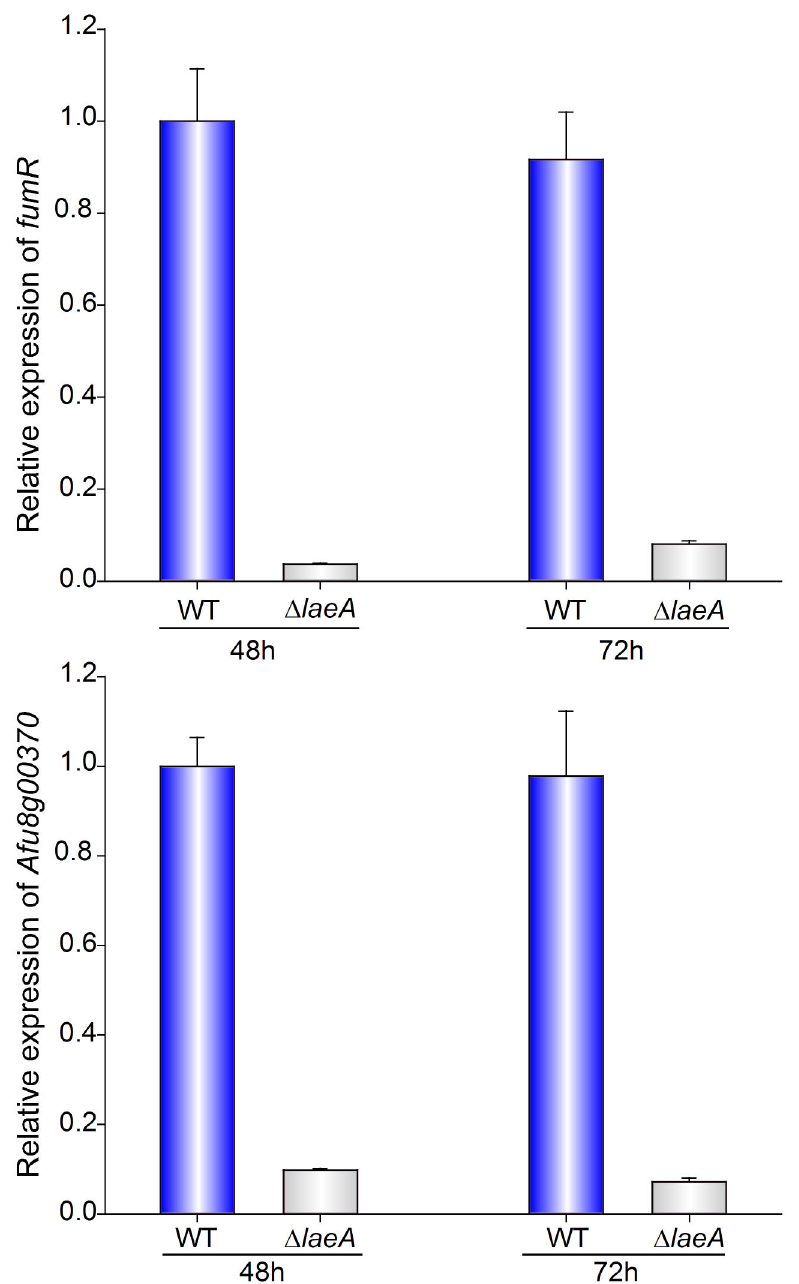
Figure 7. Expression of fumR and PKS370 is regulated by laeA . Total RNA was extracted from WT and ∆ laeA strains, grown as stationary liquid Czapek-Dox cultures for 48 h and 72 h. Relative expression of fumR and PKS gene Afu8g00370 was calculated using 2 -ΔΔCt method as described by Schmittgen and Livak [89]. Primers used for the expression analysis are listed in Table S2. The bar represents the mean of three replicates and error bars represent standard error. Expression of 18S was used as internal reference. Values were normalized to expression levels of wild-type levels considered as 1. doi: